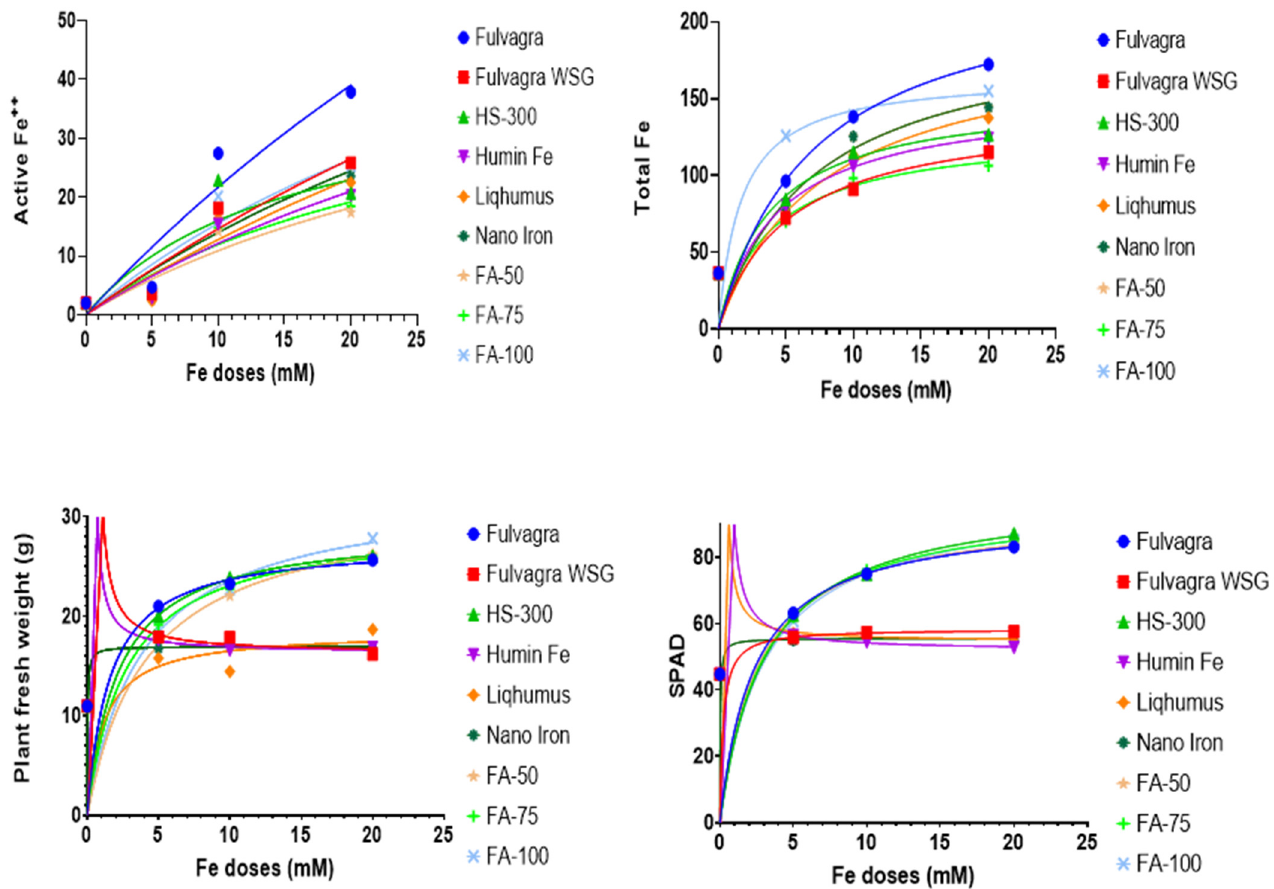
Figure 2. Regression analyses of different treatments to determine the most effective iron dose based on important agronomic properties: active Fe, total Fe, plant fresh weight, and SPAD value in spinach. Treatments Fulvagra, Fulvagra WSG, HS-300, Humin Fe, and Liqhumus contain FeSO 4 ·7H 2 O as the iron source; treatments Nano Iron, FA-50, FA-75, and FA-100 contain nano ferrihydrite as the iron source.